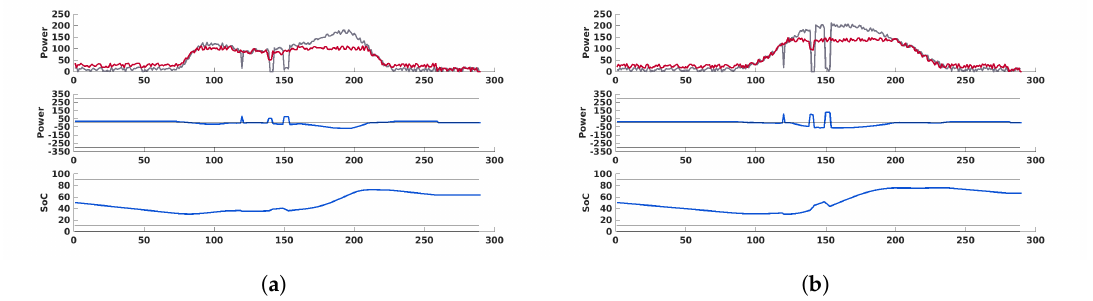
Figure 15. Top: Grid power flow with FBM-SR ( P g , red) and without FBM-SR ( P hcpv , grey). Middle: Battery power evolution ( P ess , blue) and constraints (grey). Bottom: Battery SoC evolution (blue) and constraints (grey). On a cloudy day case ( a ), on a sunny day ( b